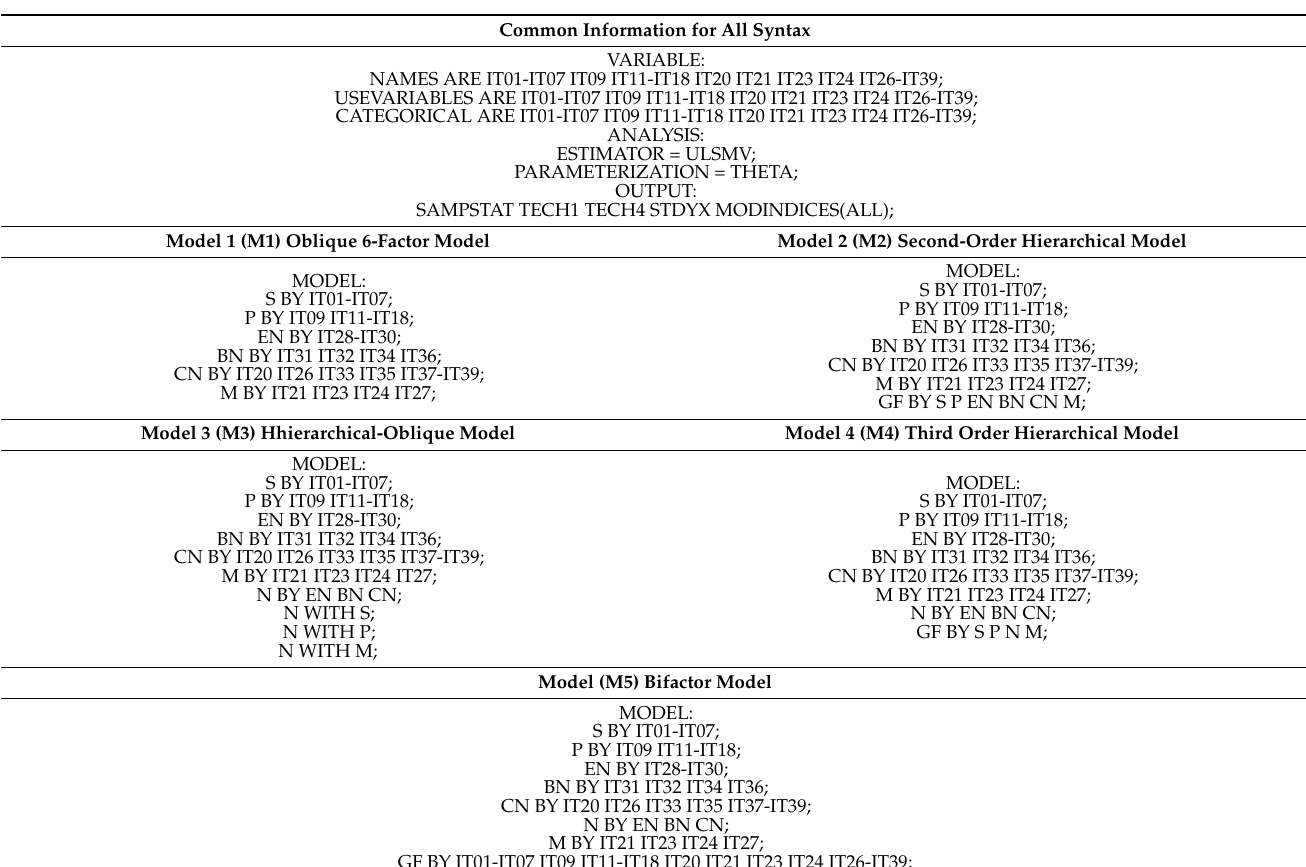
Table A2. Syntaxis Mplus for factorial models subjected to